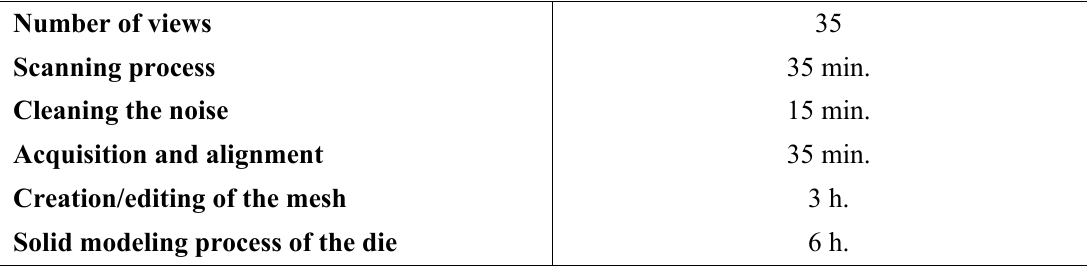
Table 1. Average duration of each task in scanning process and designing the 3D CAD model. Number of views